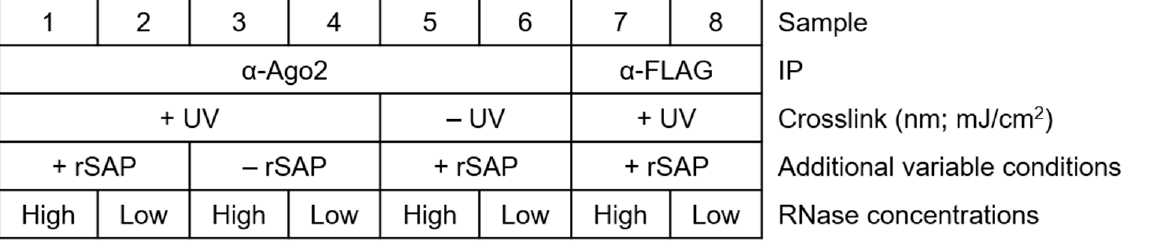
Figure 2. Simplified table showing how to sort samples and their treatments, including important control reactions. Samples with an antibody of interest and their additional variable treatments (crosslinking, rSAP treatments, ligase treatment, and NaCl concentration of stringent buffers), high- and low-RNase I concentrations, and negative controls ( α -IgG or α -FLAG antibody for IP).